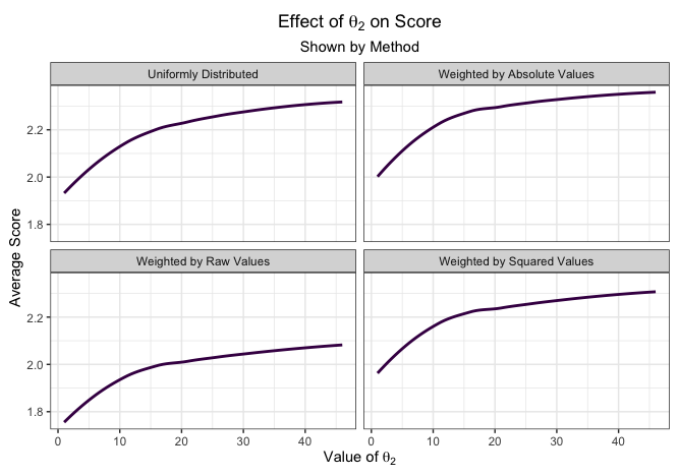
Figure 2. How θ 1 impacts overall score on average.